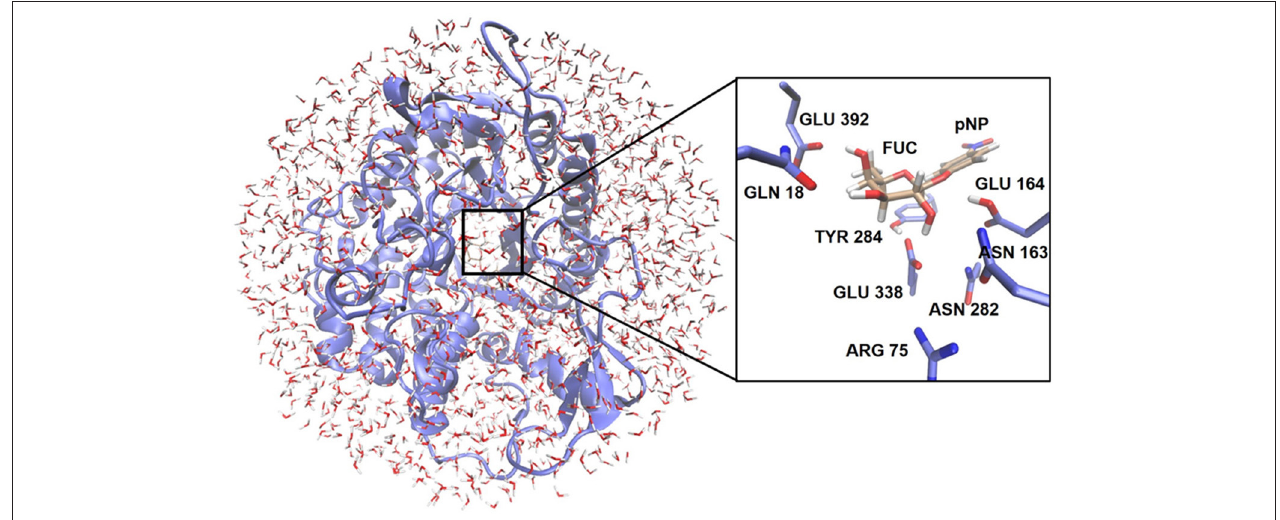
FIGURE 2 | Representation of the enzymatic model used for the QM/MM calculations. The location of the QM region is highlighted. The inset shows as an example the arrangement of the QM atoms for the glycosylation reaction at the active site.